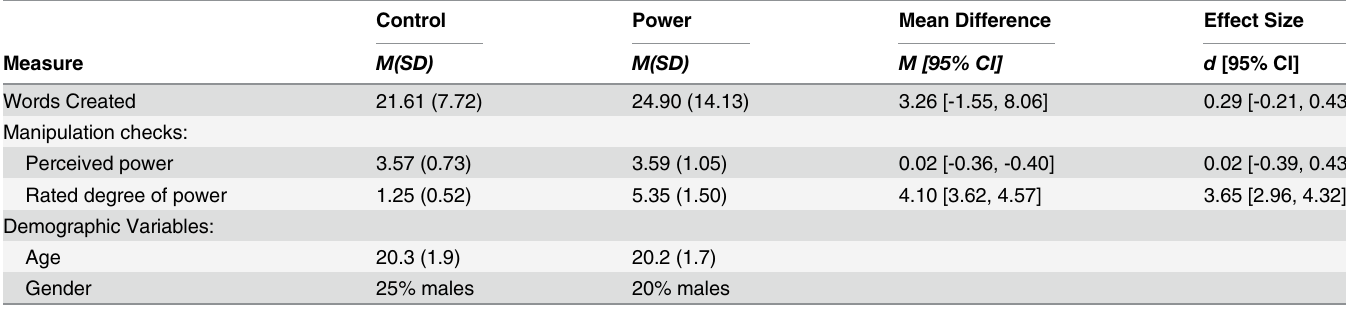
Table 5. Experiment 5: Summary of Group